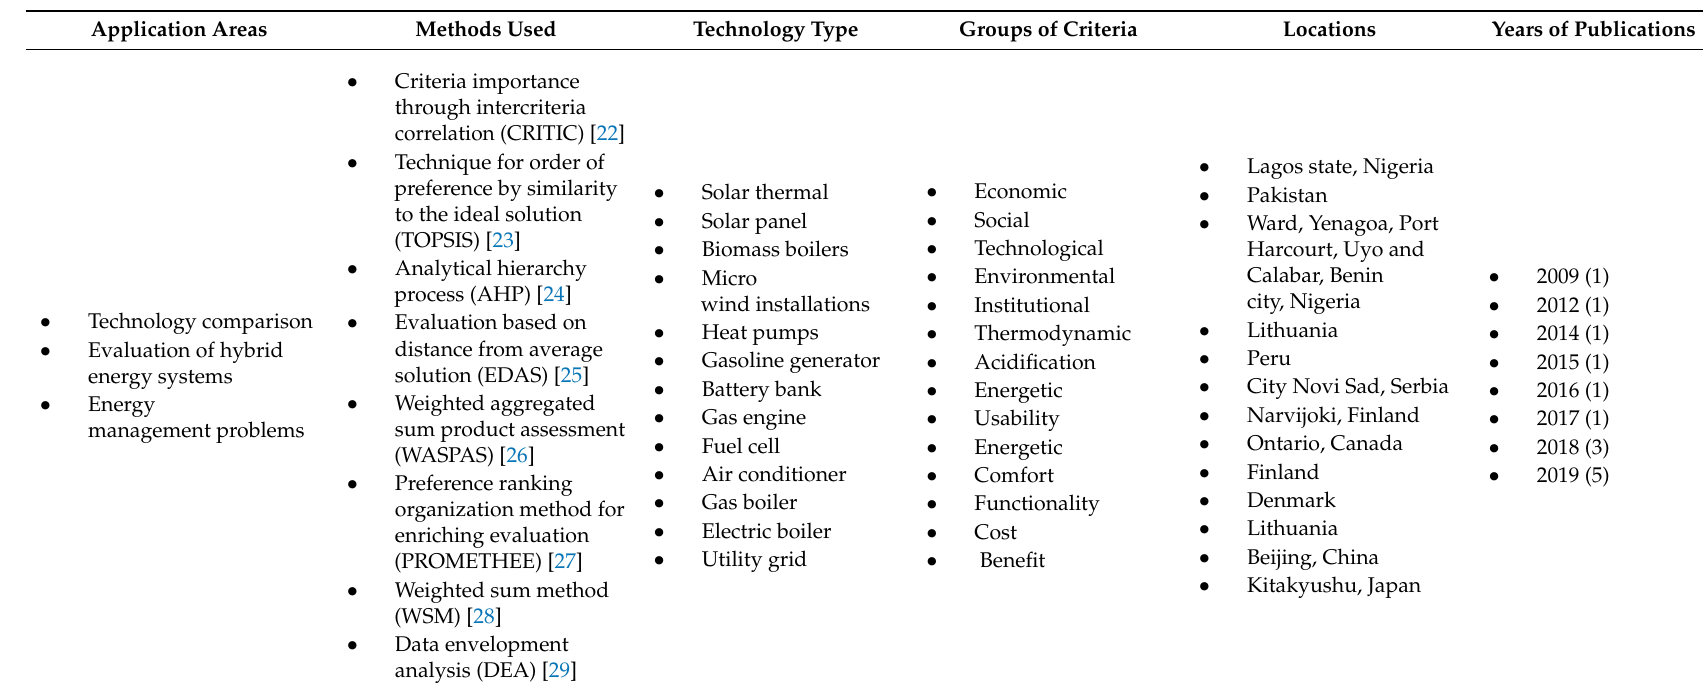
Table 1. Classification of reviewed studies on multi-criteria decision-making